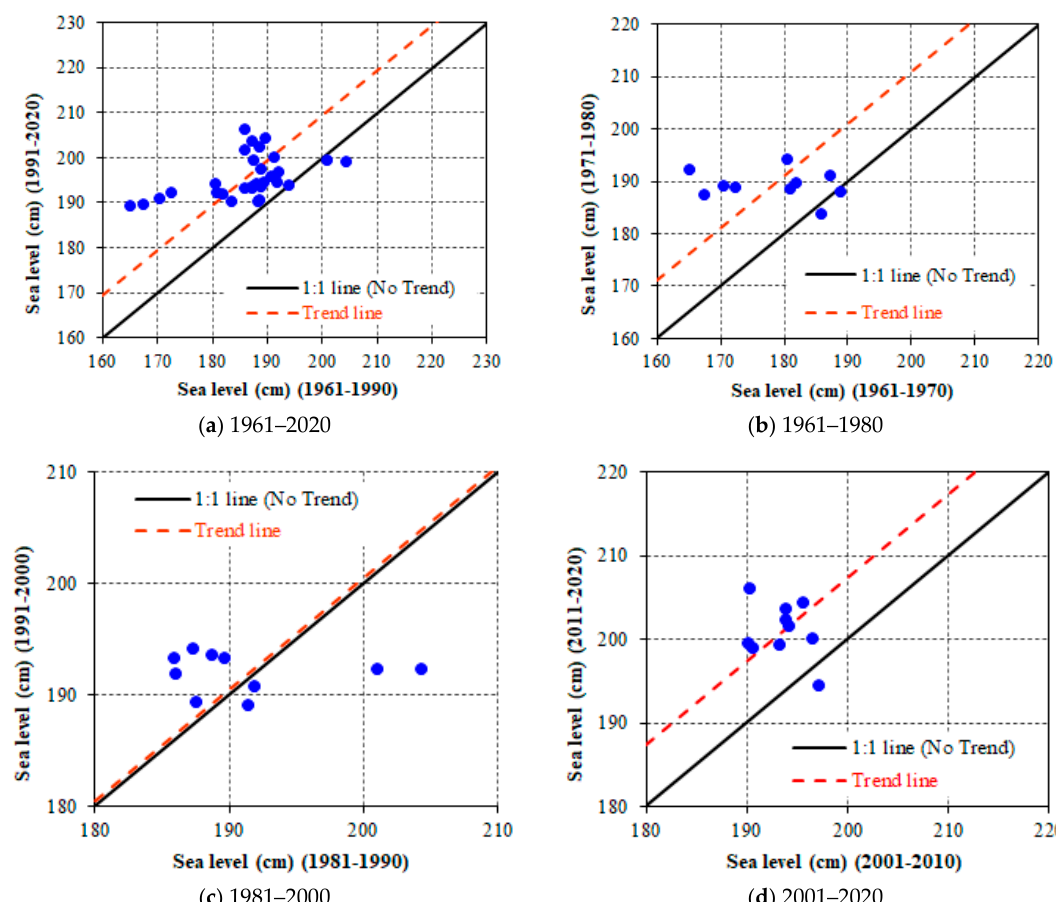
Figure 8. Results of the ITA on monthly sea level in different seasons for the Hon Dau station (2001–